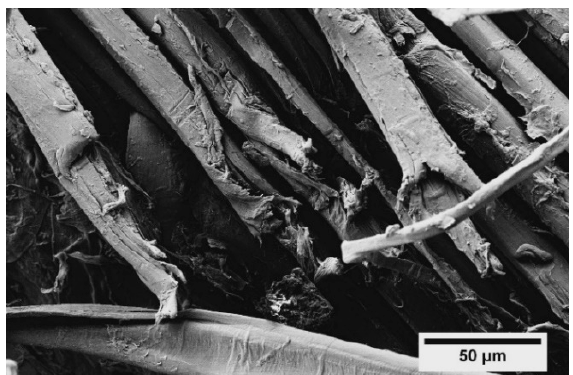
Figure 4. SEM micrograph of the flax yarn treated with 10 wt % Peclyve for 4.5 h. The micrograph shows the damage to the outer fibres of the flax yarn after the enzymatic treatment.